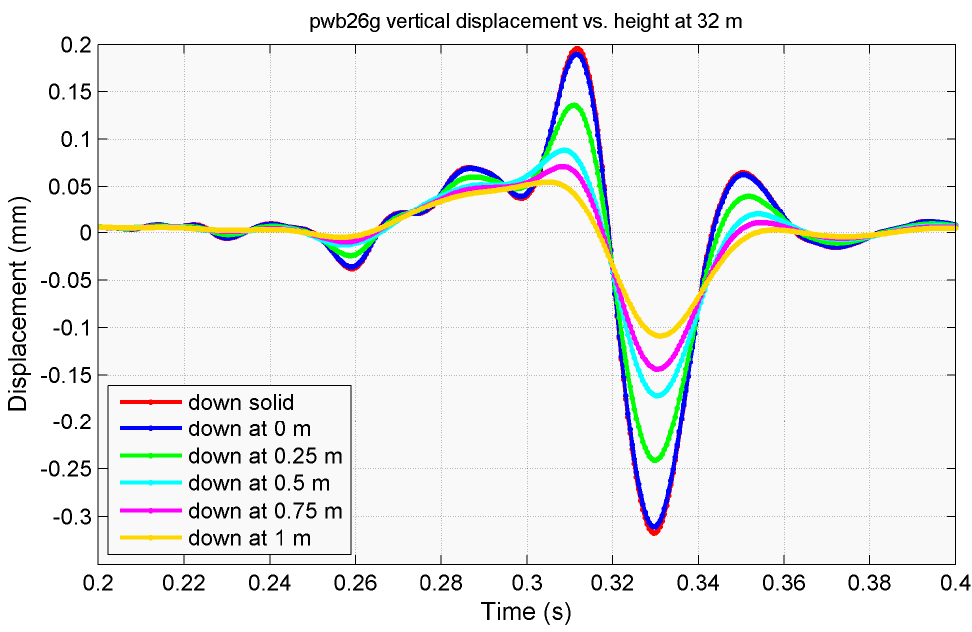
Figure 12. The vertical displacement reduces with height above the seabed.